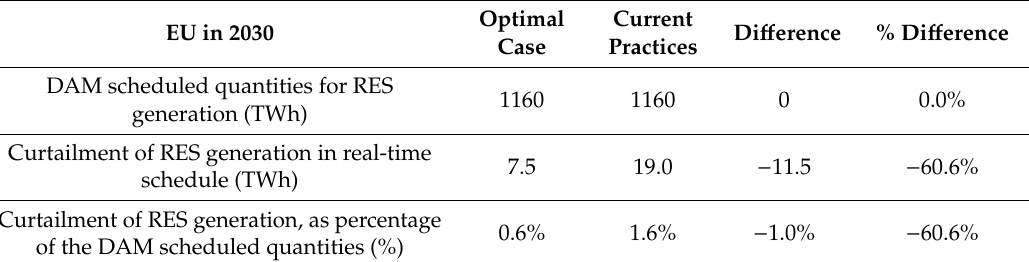
Table 9. Res generation and curtailment in real-time